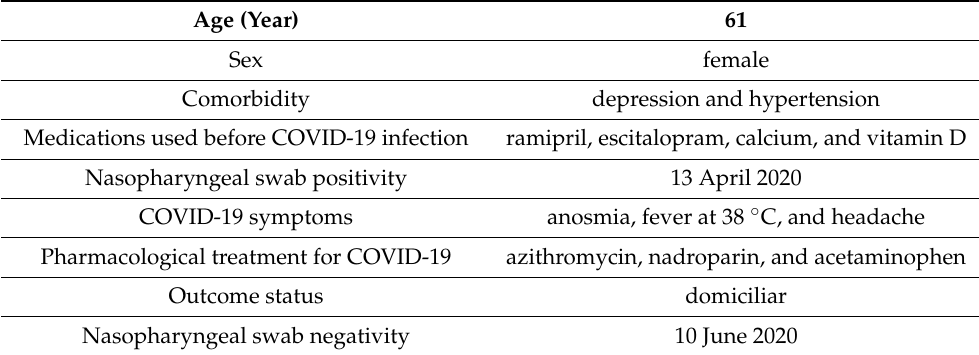
Table 1. Clinical characteristics.